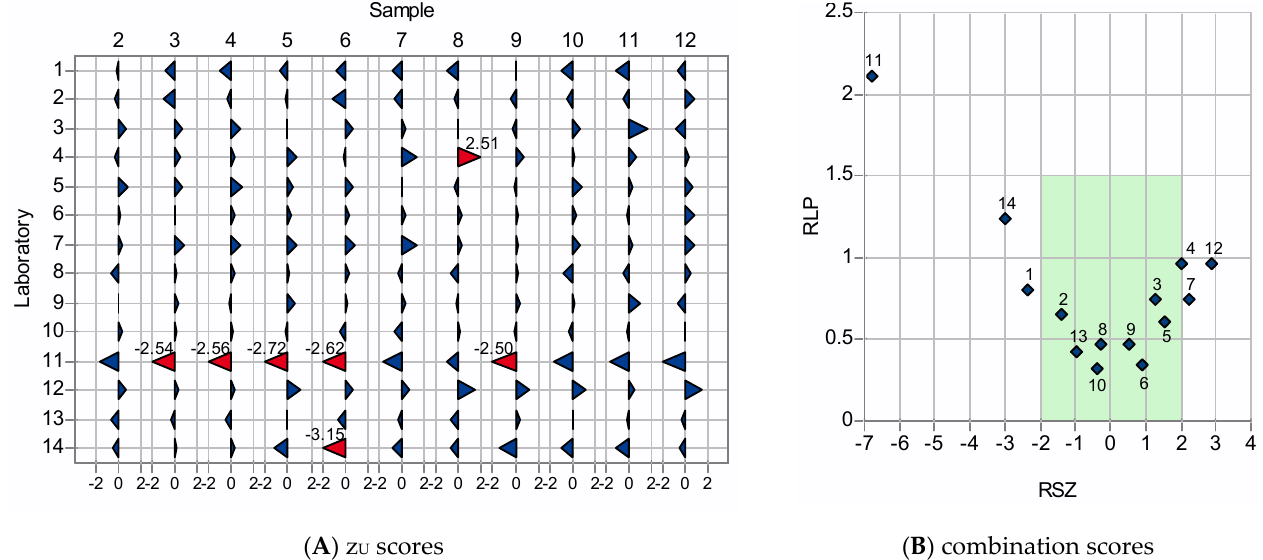
Figure 3. z U scores ( A ) and combination scores ( B ) for the determination of the roe deer content in meat samples. In ( A ), z U scores within − 2 and +2 are shown in blue, z U scores < − 2 or >+2 in red. The figure includes laboratories which were identified as outliers.